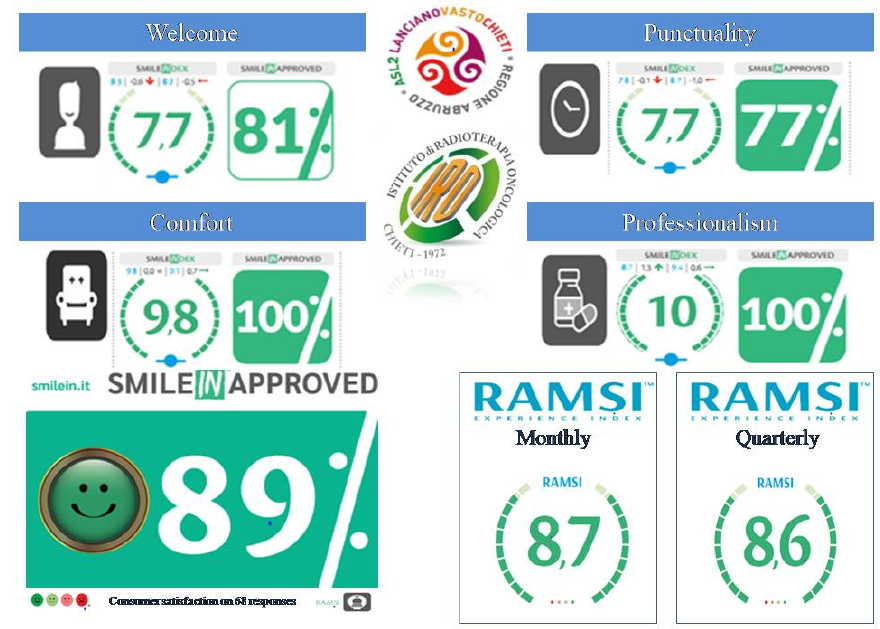
Figure 1. Example of a monthly report of patient-reported experience measures (PREMs), SmileIN- approved and SI Index showed inside the department and available for the patients and clinicians.